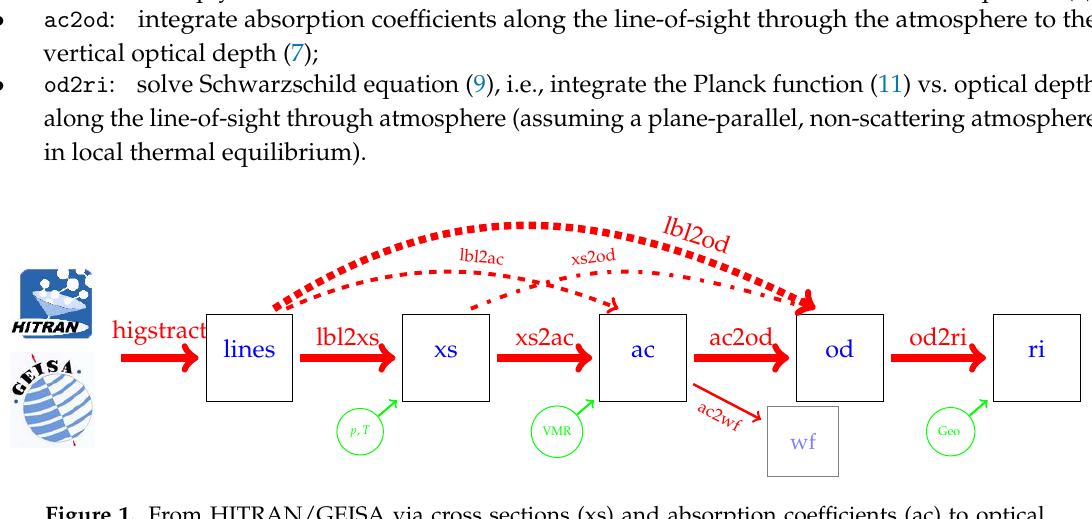
Figure 1. From HITRAN/GEISA via cross sections (xs) and absorption coefficients (ac) to optical depths (od) and radiation intensity (ri). Please note that cross sections are pressure and temperature (pT) dependent, absorption coefficients also depend on composition (VMR), and optical depth and radiation intensity depends on path geometry (geo).